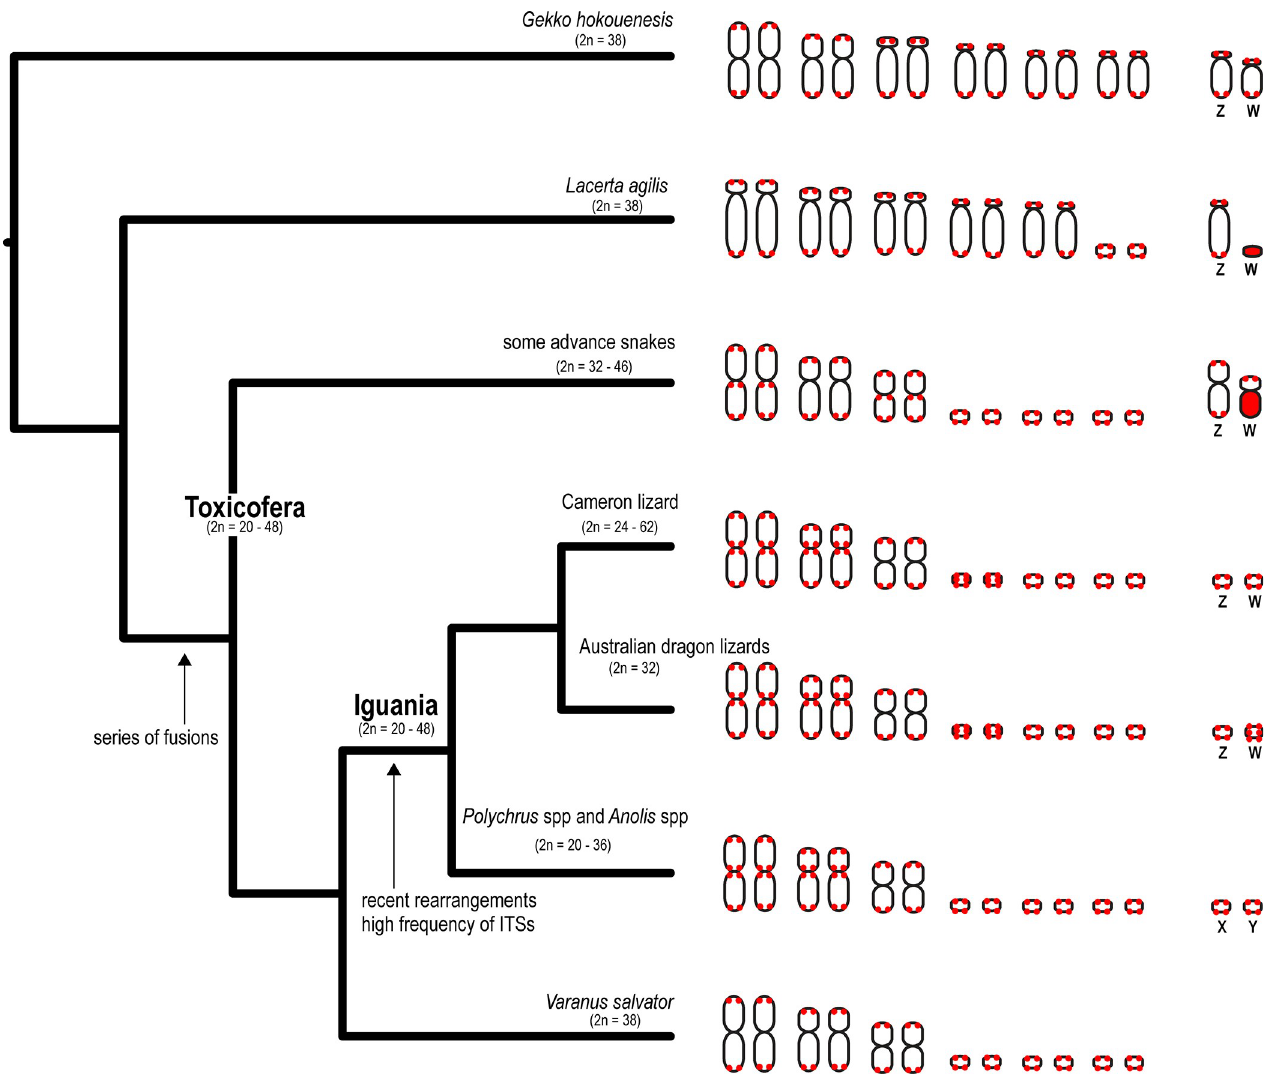
Fig 4. Schematic representation of the distribution of interstitial telomeric sites (ITSs) in centromeric or pericentromeric regions on chromosomes and amplification of telomeric repeats on sex chromosome in lizards and snakes. Phylogeny was partially derived from Pyron et al. [39]. Distribution of ITSs and telomeric repeat amplifications of lizards and snakes were also obtained from Young et al. [11], Matsubara et al. [37], Augstenova´ et al. [34], Rovatsos et al. [23,30] and Srikulnath et al. [7,9].